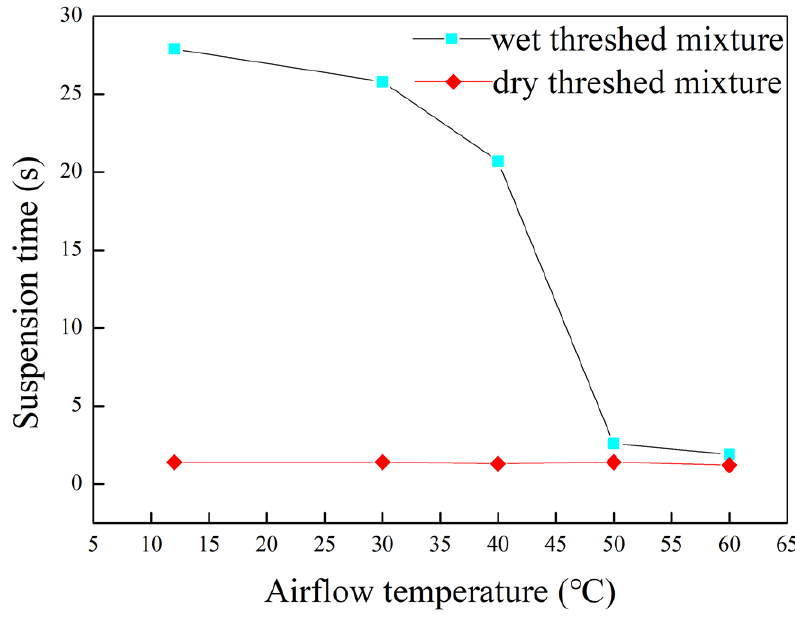
Figure 5. Suspension time with